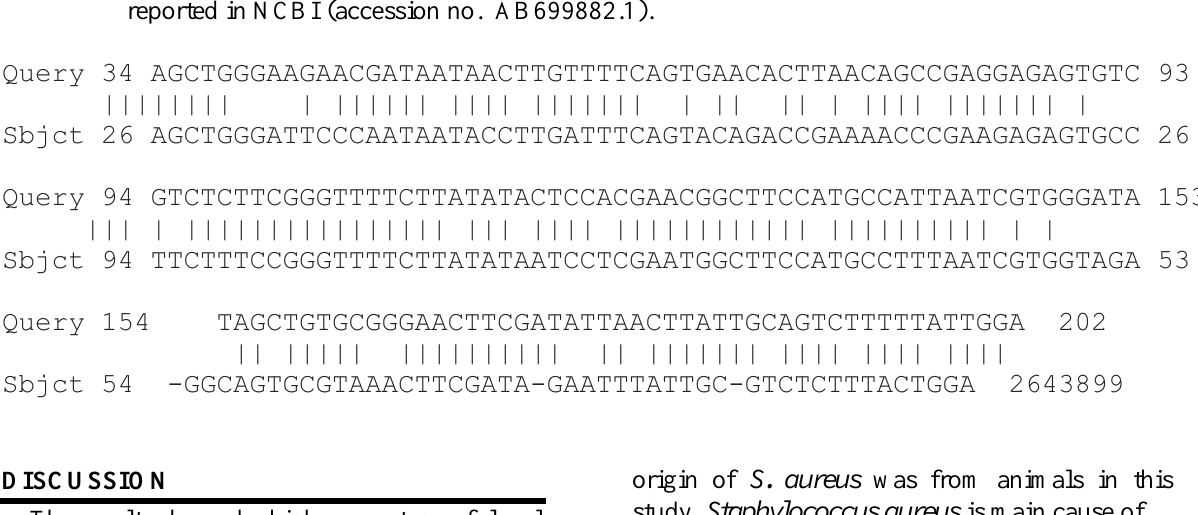
Figure 3: Sequence and identity a part of third S. aureus tnp gene of this study and that of PM1 strain as reported in NCBI (accession no.